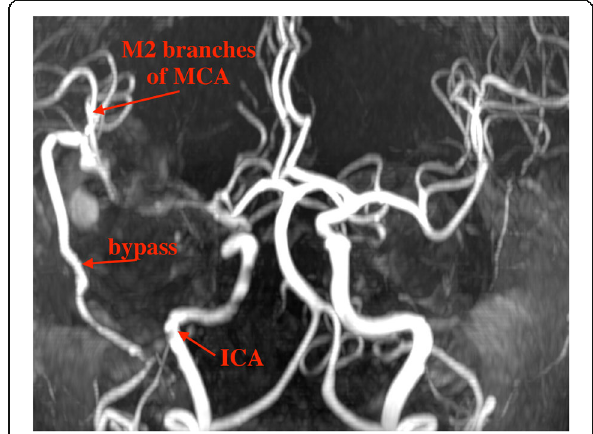
Fig. 8 MRI angiography revealed a total aneurysm occlusion and good filling of distal MCA